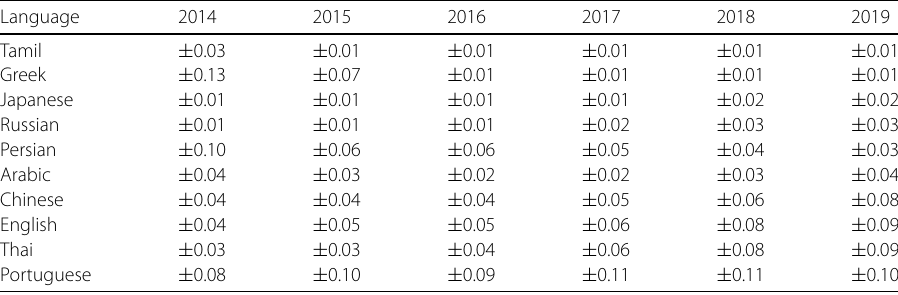
Table 5 Bottom 10 languages with the lowest average margin of error for estimating contagion ratios as a function of the agreement between FastText-LID and Twitter-LID (sorted by 2019) Language 2014